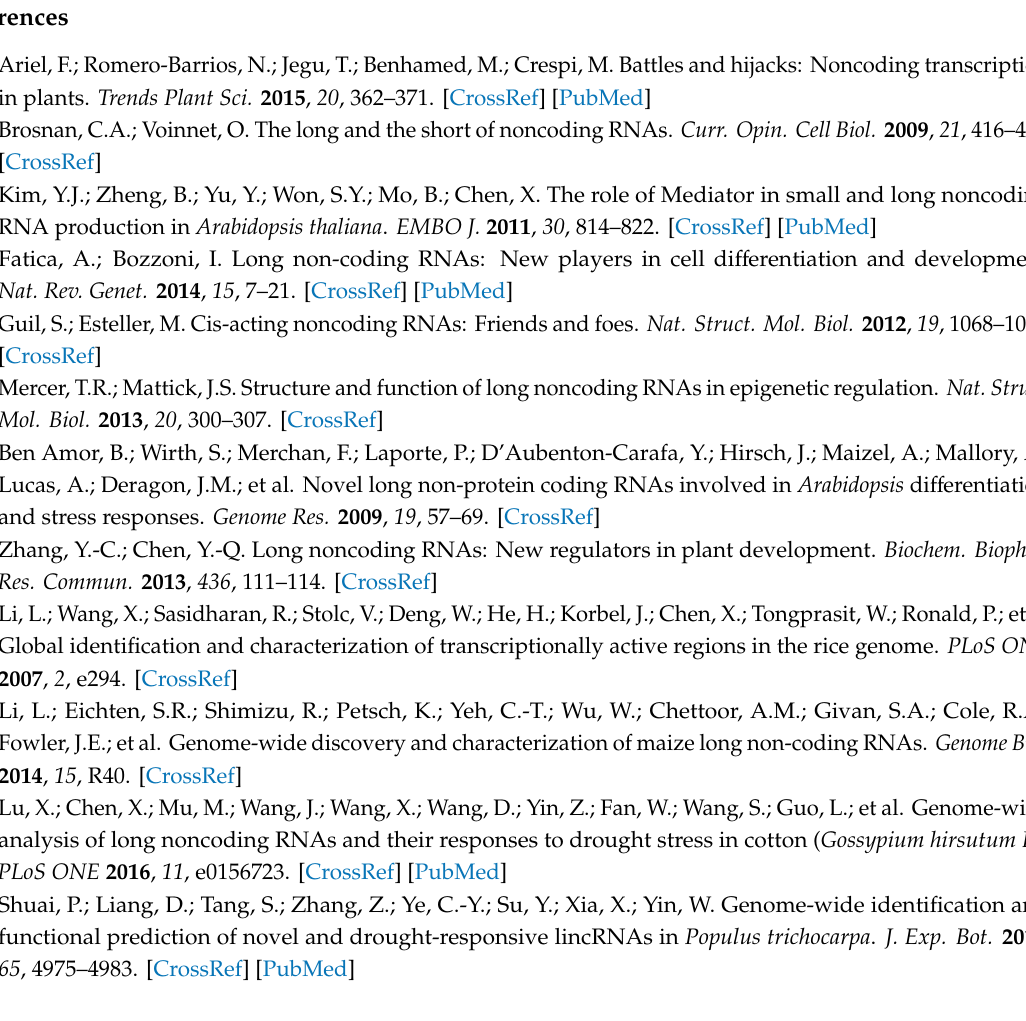
Figure S1: Comparison of genome distribution of DE lncRNAs and mRNAs. Table S1: Stress response GO terms responding to F. graminearum attack. Table S2: Primers and sequences used in qRT-PCR analysis. Table S3: Characters of lncRNA and mRNA obtained by RNA-seq. Table S4: Identification of di ff erentially expressed lncRNAs from coleoptiles infected by F. graminearum . Table S5: LncRNAs and putative target genes used in network